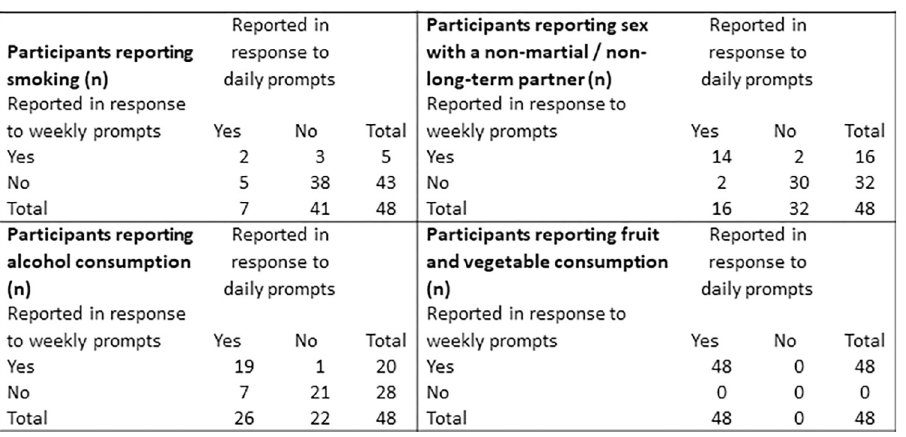
Of the 5,001 event-contingent submissions received, 76% reported fruit consumption, 51% reported vegetable consumption, while � 4% reported alcohol use, sex with a non-marital or non-long-term partner, or smoking. (Fig 4) Approximately half, 48% (n = 23), of participants submitted at least one event contingent report of sex with a non-marital or non-long-term partner. Of the sexual encounters reported, 52% did not include condom use. Just under one quarter of participants (n = 11) reported smoking, half (n = 24) reported alcohol consumption, and all (n = 48) reported fruit and vege- table consumption. Average number of reported cigarettes smoked in the hour prior to sub- mission was 1.5 (min: 0, max: 6). Average consumption of vegetables and fruit reported was 1.5 (min: 0, max: 11) and 1.4 (min: 1, max: 14), respectively. During data cleaning, nine quan- tity report outliers were excluded from event contingent reporting data ( < 0.2%).